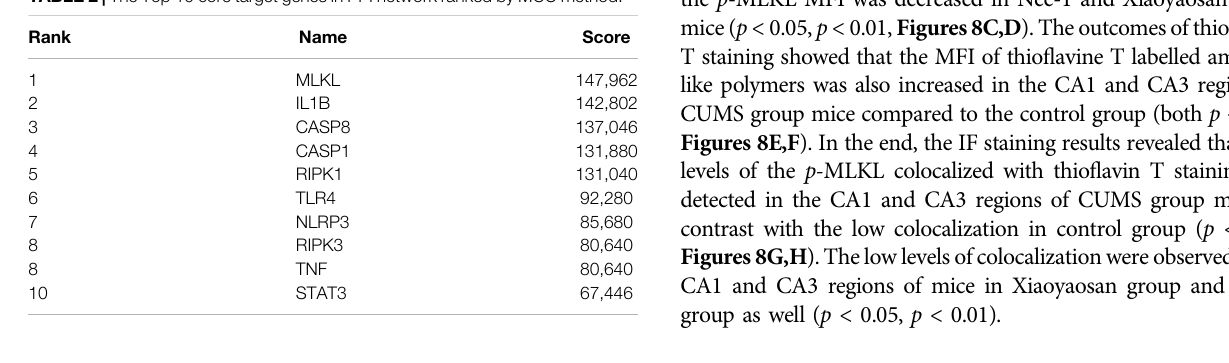
TABLE 2 | The Top 10 core target genes in PPI network ranked by MCC method.